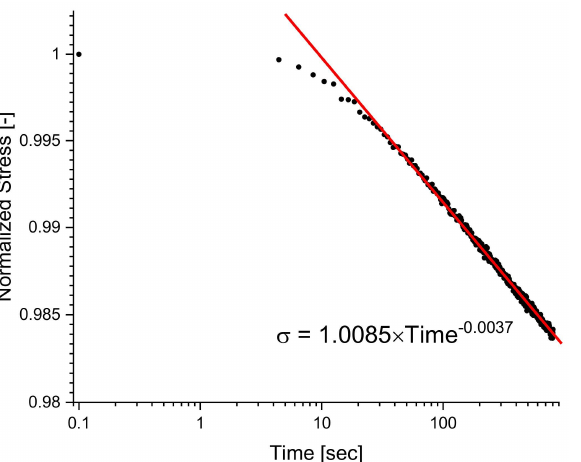
Figure 4. This shows the raw relaxation curve which can be fit to a power function to quantify the long-term behavior under relaxation.